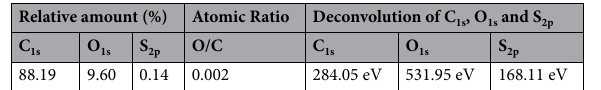
Table 4. XPS data for AAC-CC.